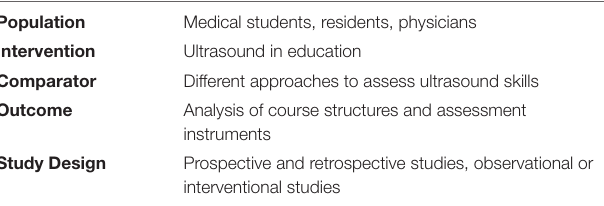
TABLE 1 | Key questions of ultrasound methods and medical ultrasound